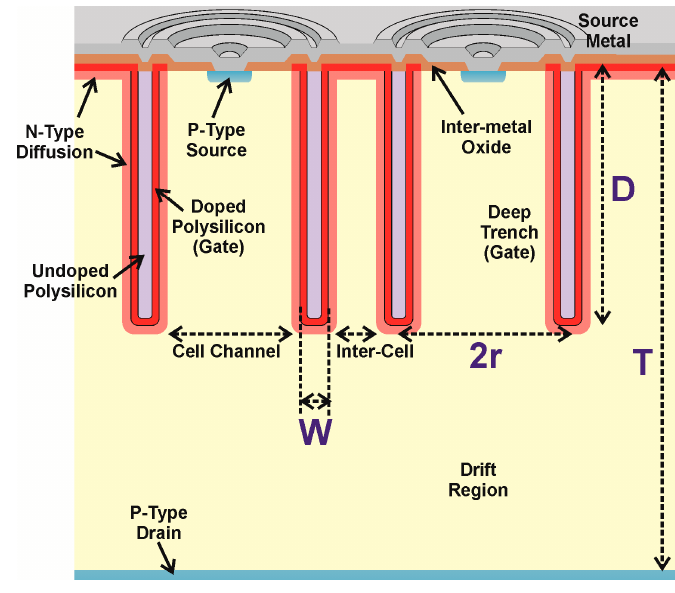
Figure 1. Schematic cross section through the center of two adjacent V-JFET cells.